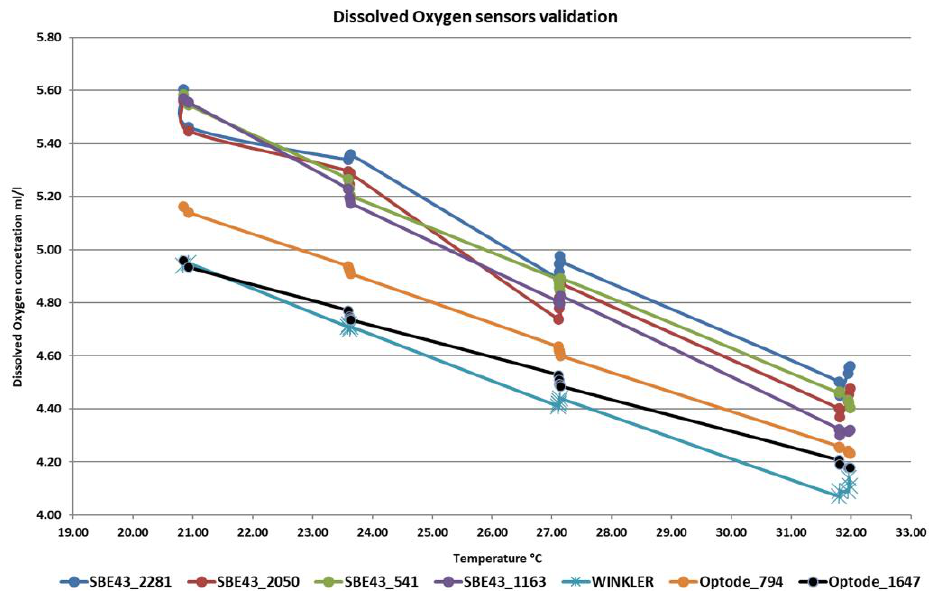
Figure 6. The dissolved oxygen sensor validation procedure. Data from 6 sensors are compared with the results of the Winkler analysis during an experiment where the seawater temperature was technically raised in order to reduce the dissolved oxygen concentration.